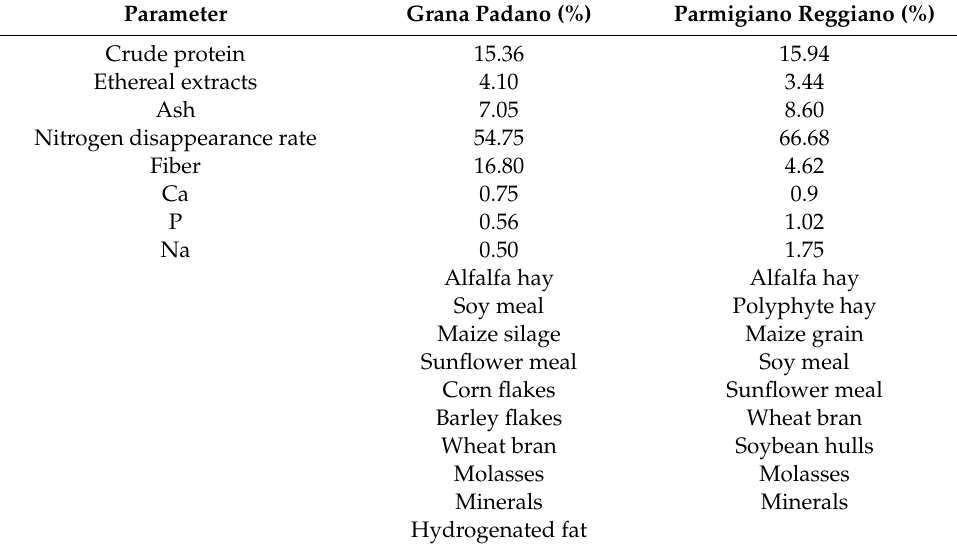
Table 1. Parameters for the dietary treatments for the two groups of